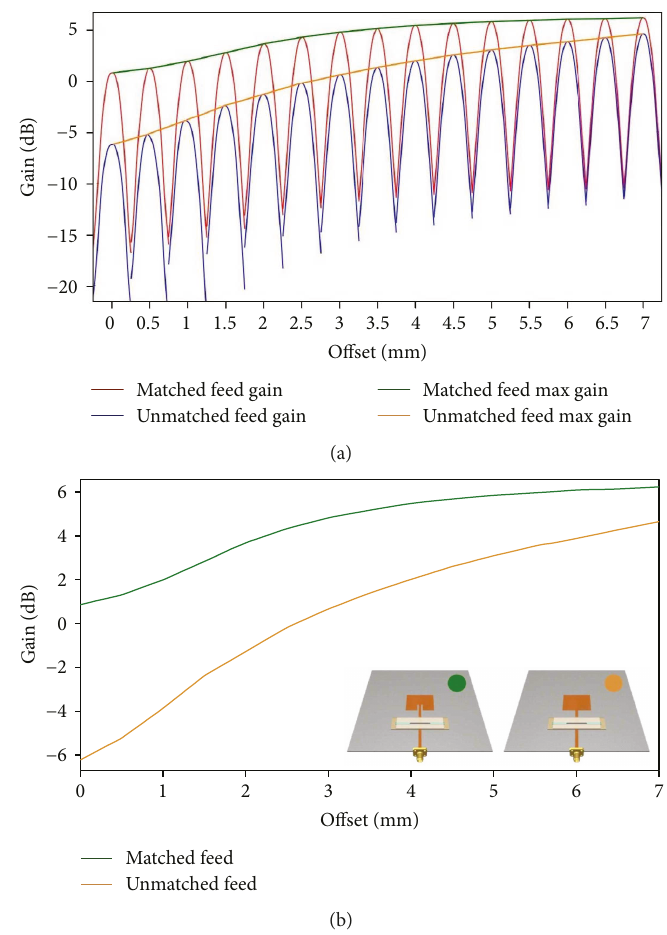
Figure 7: Simulated matched 50 Ω inset-fed liquid-metal antenna versus simulated unmatched 245 Ω edge-fed liquid-metal antenna: (a) simulated gains of 15 states; (b) simulated maximum gains of 15 states.